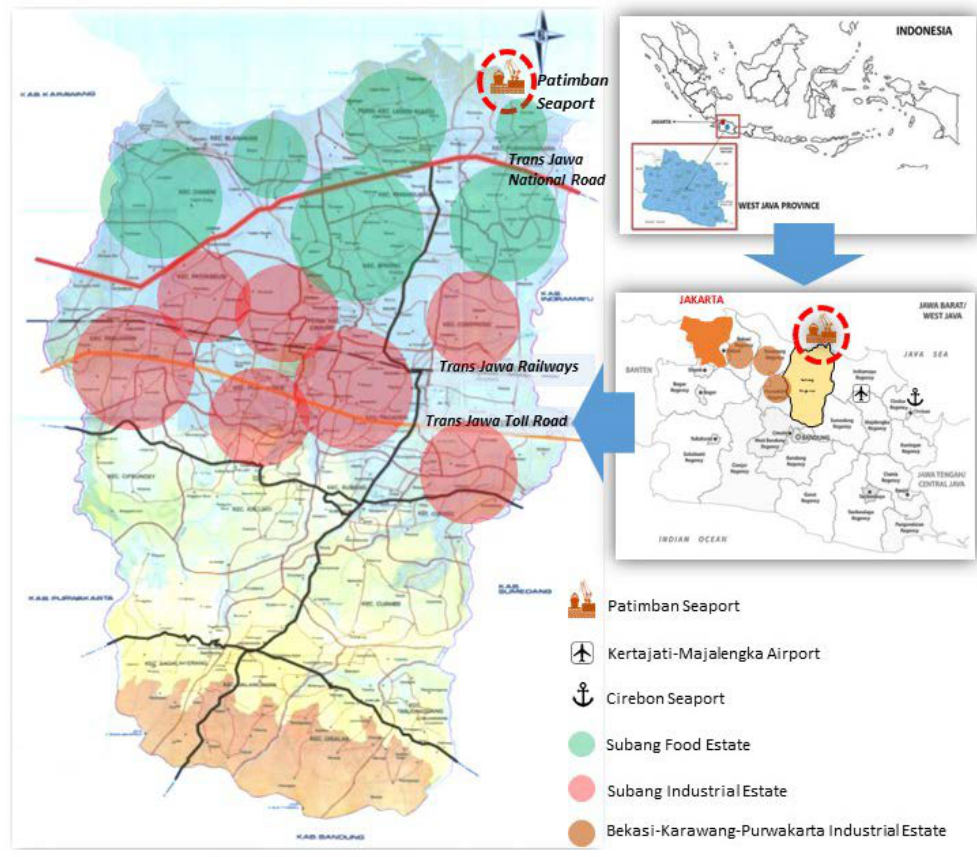
Figure 1. Map of Patimban Seaport. Source: BAPPEDA Subang Regency, modified by authors.